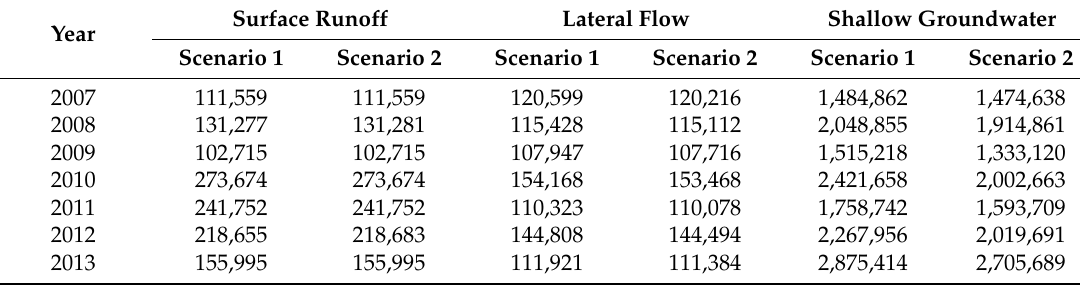
Table 5. The results of nitrogen changes in different pathways for scenario analysis (kg · year − 1